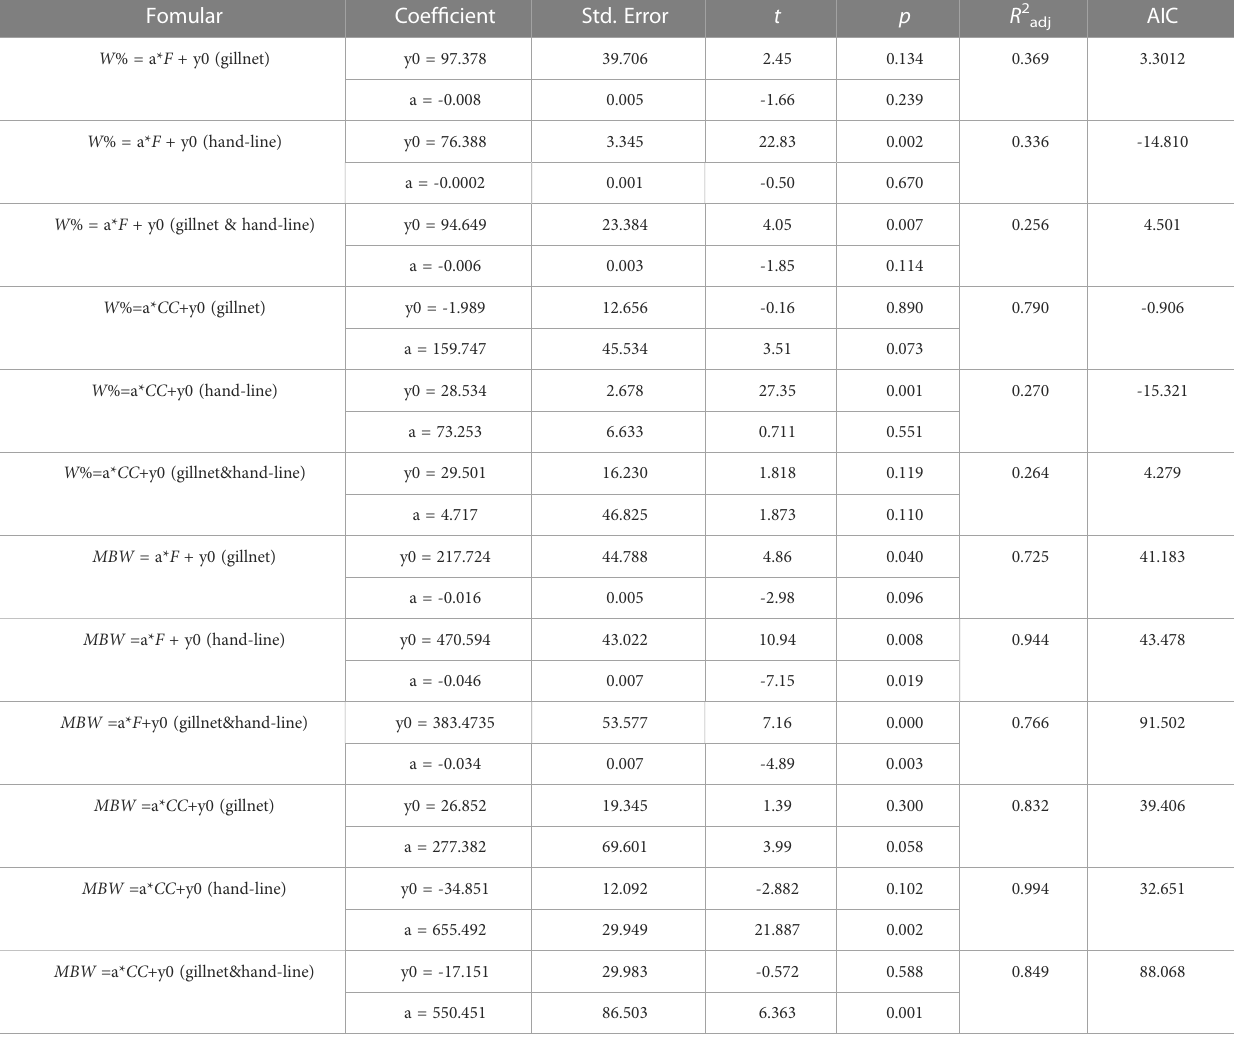
TABLE 5 Linear fi t parameters between weight percentage ( W ) and mean body weight ( MBW ) of very high & high-value fi sh by gillnet and hand-line in the lagoon of in Meiji Reef and fi shing power ( F ) and coral cover ( CC ). Fomular Coef fi cient Std.